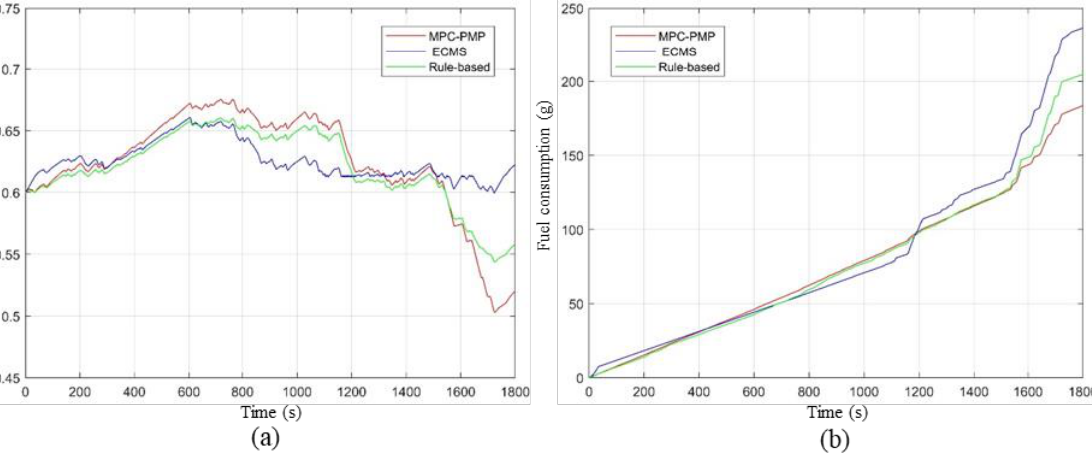
Figure 10. Optimized results under WLTC conditions: ( a ) SOC waveform of battery; ( b ) fuel con- sumption.